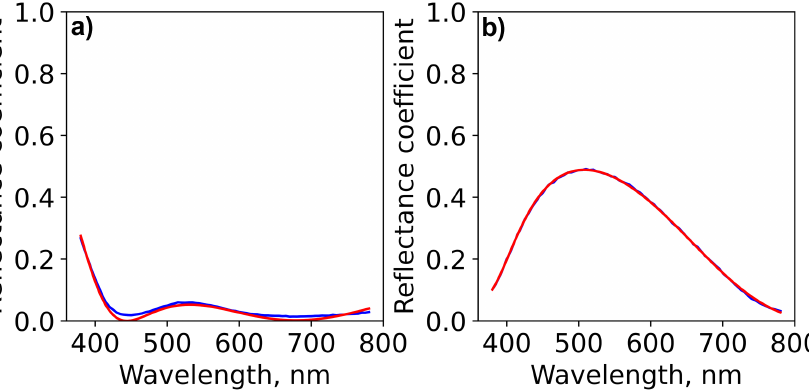
Figure 4. The predicted (blue) and anticipated (red) reflectance spectra produced by the SNN for two different structures, demonstrating its ability to predict a variety of spectral shapes. The percentage accuracies for ( a , b ) are 77% and 99%, with layer depths [21 10 50 30 60 60] and [40 50 30 10 60 50] nm,